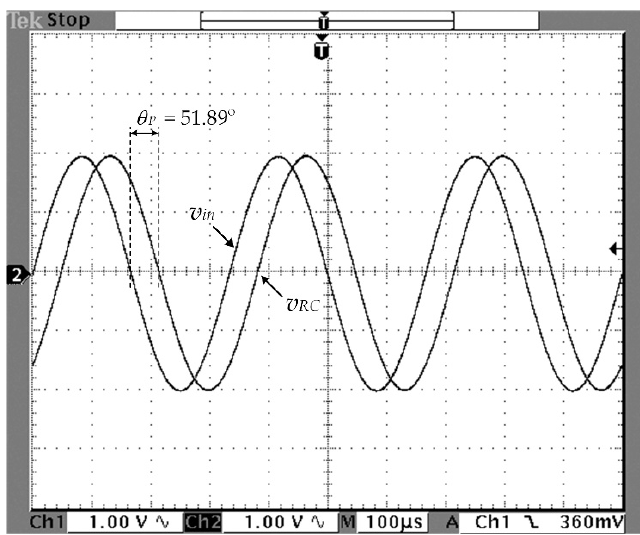
Figure 5. Measured result of signals v RC and v in .